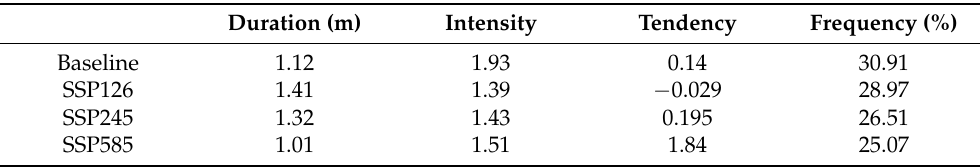
Table 4. Comparison of drought characteristics between the future scenarios (2015–2100) and baseline (1961–2014). The “m” is